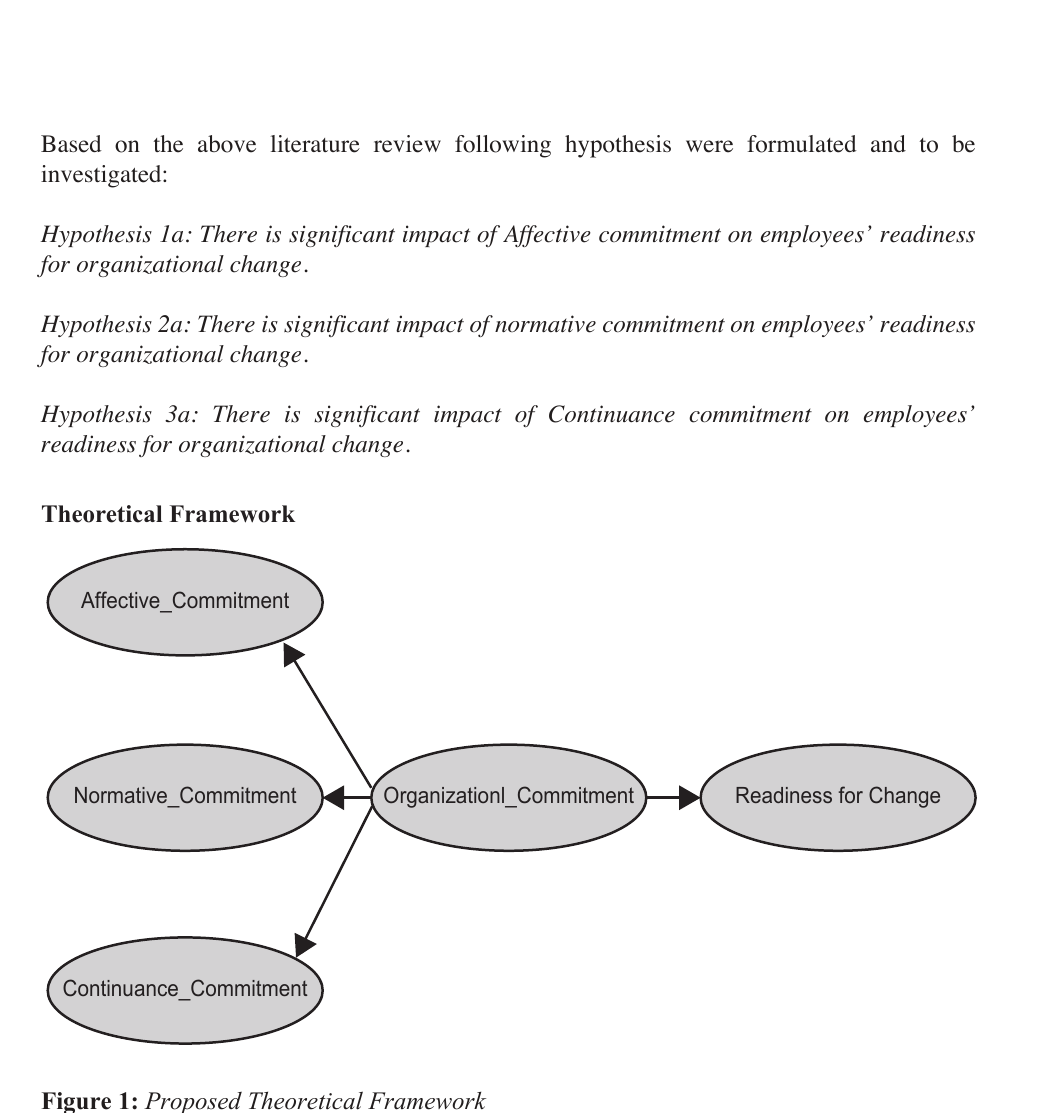
Figure 1: Proposed Theoretical Framework